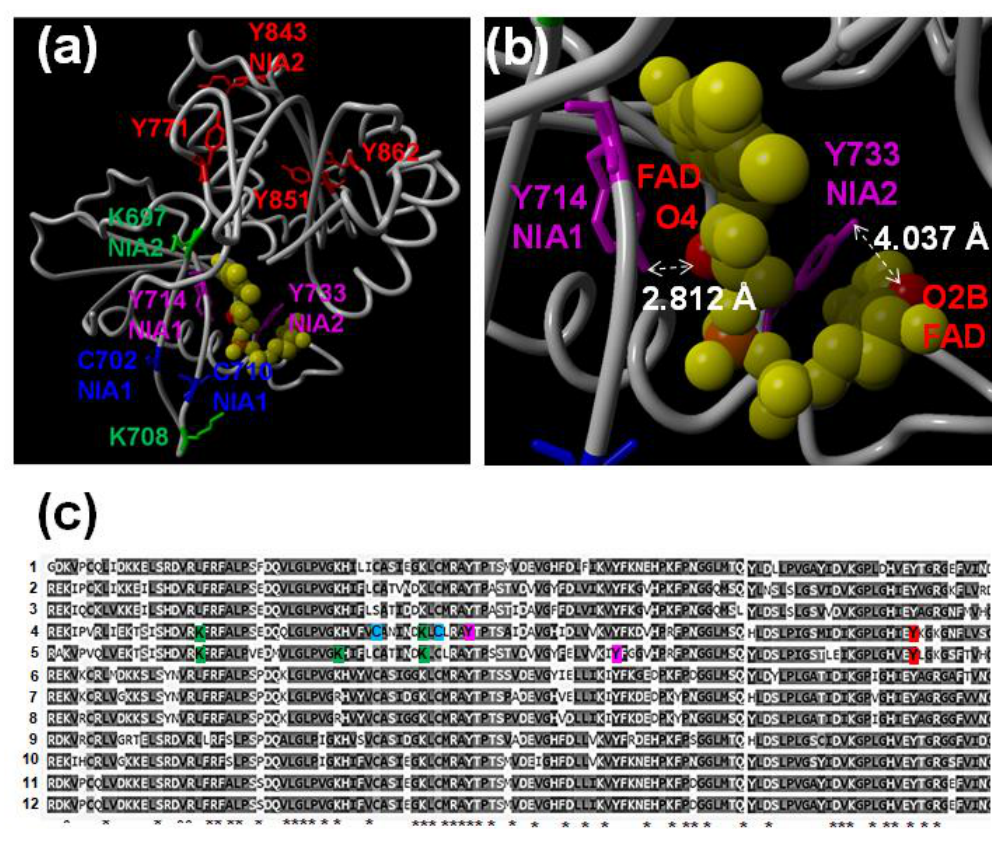
Figure 5. Location of the identified nitrated Y (red), aminated Y (magenta), S-nitrosated C (blue), and ubiquitylated K (green) residues of NIA1 and NIA2 proteins in the FAD-binding domain. ( a ) Post-translationally modified residues identified in arabidopsis were located based on homology sequence in the 3D structure model of the corn nitrate reductase (PDB code 2cnd) by using Yasara view application. FAD is colored in yellow. ( b ) Detail of the FAD-binding pocket showing the distance from the hydroxyl group of Y aromatic ring and the O2B and O4 atoms of the FAD molecule. ( c ) Degree of conservation of the identified modified amino acids in NRs from Rice (1, 6, 11 and 12 correspond to Os10g17780.1, Os02g53130.1, Os08g36480.1, Os08g36500.1), arabidopsis (4, and 5 corresponds to AtNIA1and AtNIA2), Populus tritocharpa (2,3 correspond to POPTR_0005s16180, and POPTR_0002s089300), and maize (7, 8, 9, 10 correspond to GRMZM2g428027, GRMZM5g878558, GRMZM2g076723, and GRMZM2g568636) plants. Sequence alignment was performed with Clustal omega. * below are fully conserved amino acids in NRs from different plants.